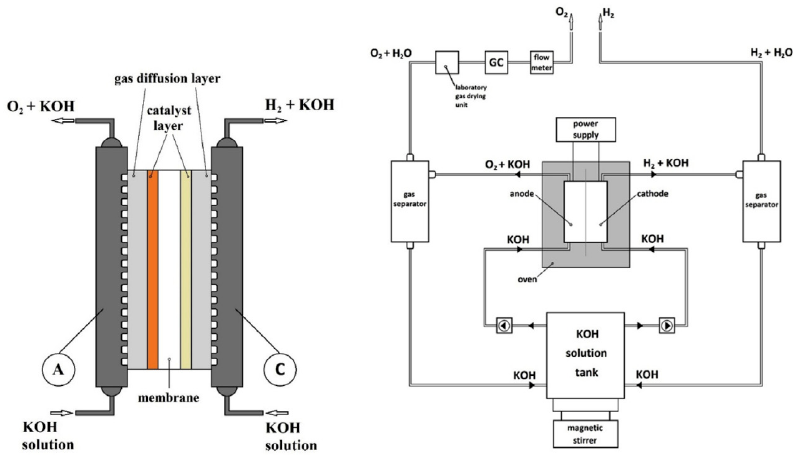
Figure 10. Scheme of the zero-gap cell (left) and the electrolysis cell testing bench